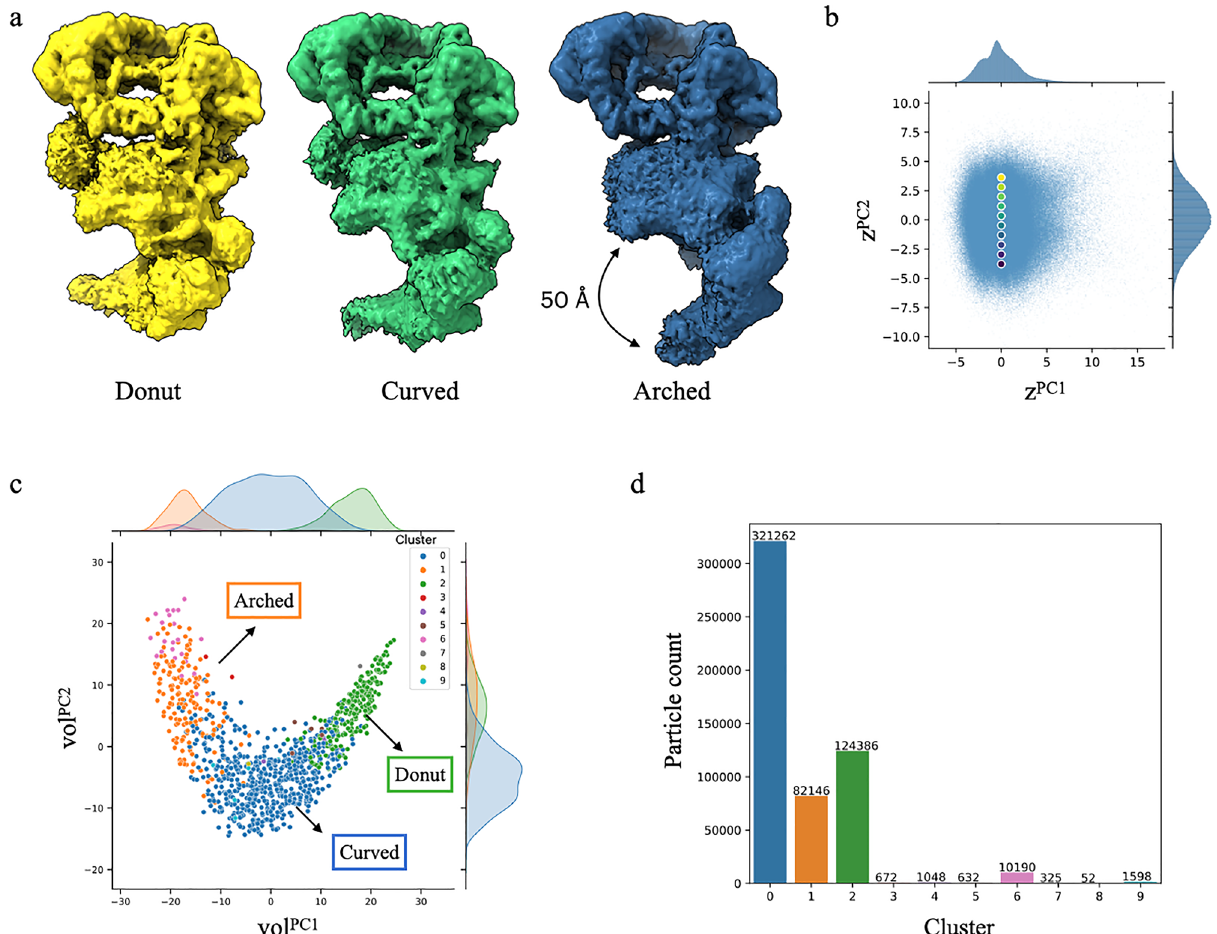
Figure 4. cryoDRGN heterogeneous reconstruction of SAGA. ( a ) CryoDRGN reconstructed density maps of SAGA in “donut”, “curved”, and “arched” conformations. Visualized density maps were generated at the 5th, 50th, and 95th percentile along the principal component (PC) 2 axis of the dataset’s latent embeddings. The view of the SAGA maps is rotated 180° compared to the density maps in Fig. 2a to allow better visualization of the tail region. Note that the prominent DUB module cannot be visualized in this orientation and the TBP density is also slightly obstructed. ( b ) PCA projection of the latent embeddings of SAGA particle images. Points depict a traversal of latent embeddings along the PC2 axis corresponding to density maps in (a) and Supplementary Video S1. ( c ) Clustering of the cryoDRGN volume ensemble. The three largest clusters are labeled according to the associated conformation of SAGA. ( d ) Number of particles in each cluster. All figures were prepared using cryoDRGN 26